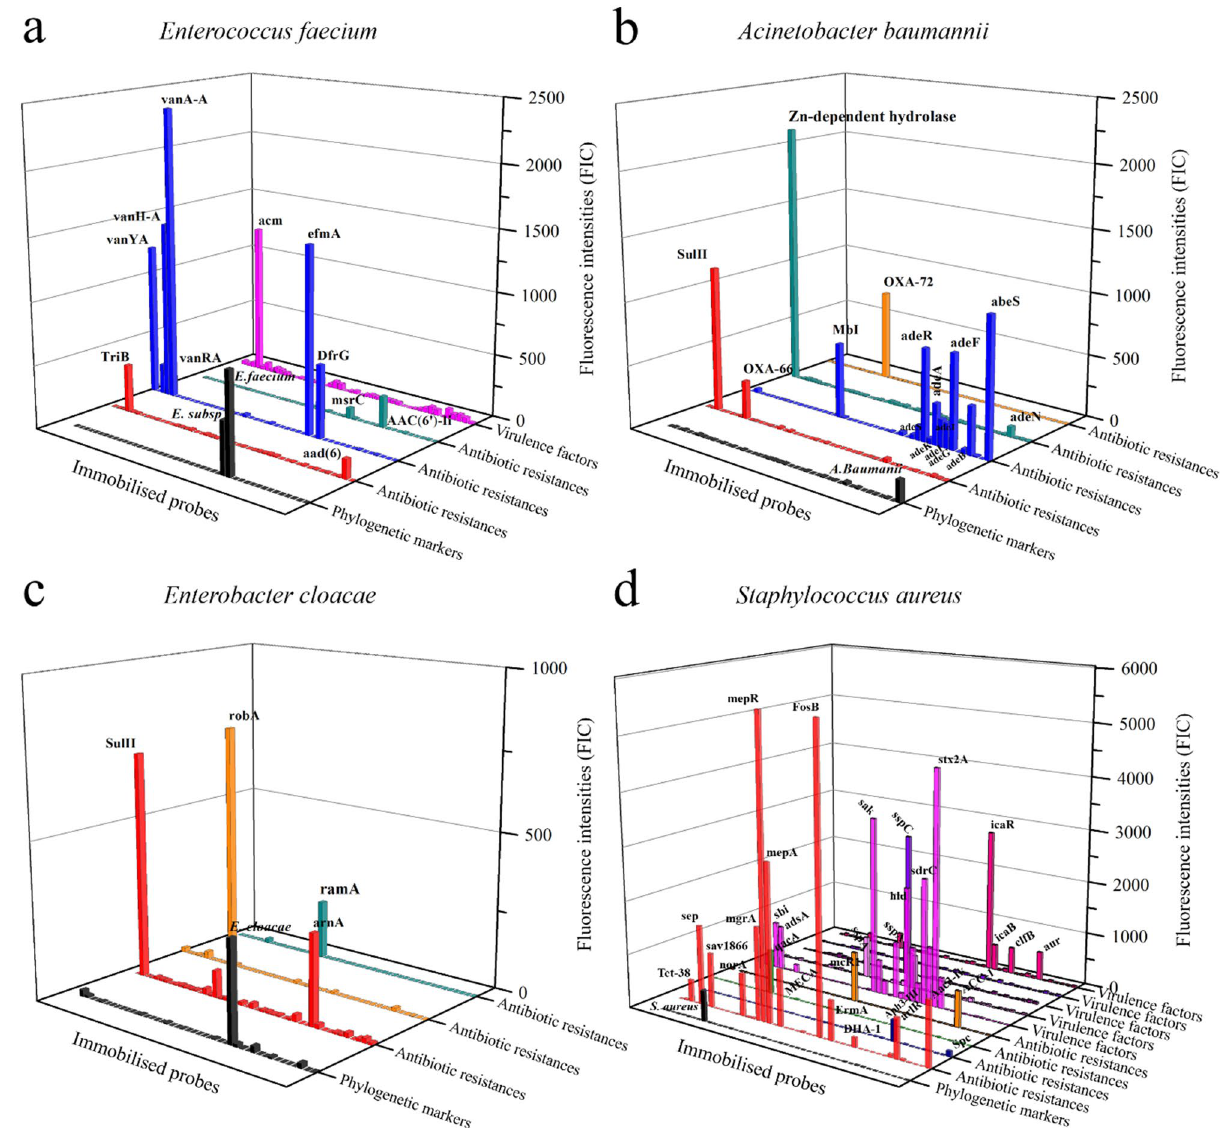
Figure 3. Full characterisation of Enterococcus faecium ( a ), Acinetobacter baumannii ( b ), Enterococcus cloacae ( c ), and Staphylococcus aureus ( d ) isolates, comprising identification (black) via 16S rRNA genes and characterisation in terms of ABR genes (red/blue/green/orange) and VFs (magenta and related colors). The DNA of a clinical isolate carrying the specified pathogen was purified and amplified by multiplex PCRs including the primer pairs of all investigated genes. The amplification products were applied to the microarray chips along with detection oligonucleotides. If matching, the detection oligonucleotides could be ligated to the probes and subsequently detected by a standard fluorescence-based microarray